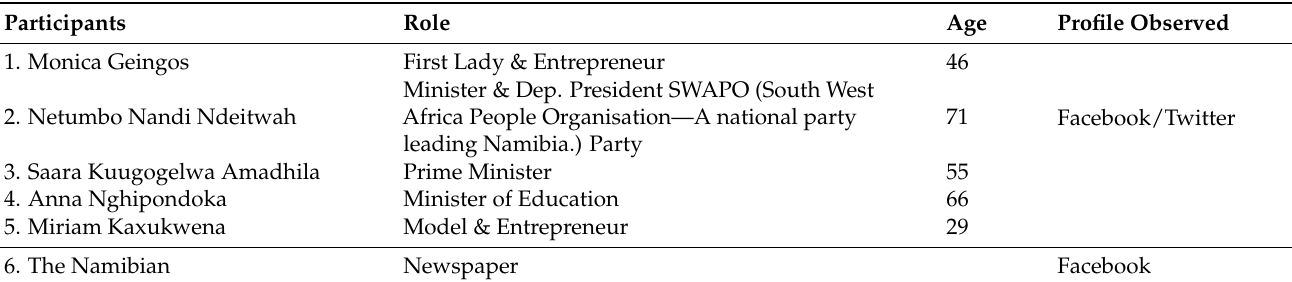
Table 3. Profile of Namibian public figures observed on social media.